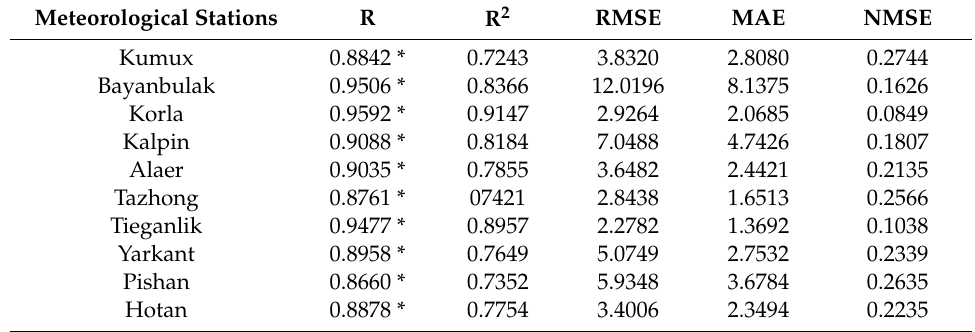
Table 3. Accuracy test of downscaling precipitation from 2001 to 2017 based on observation data.